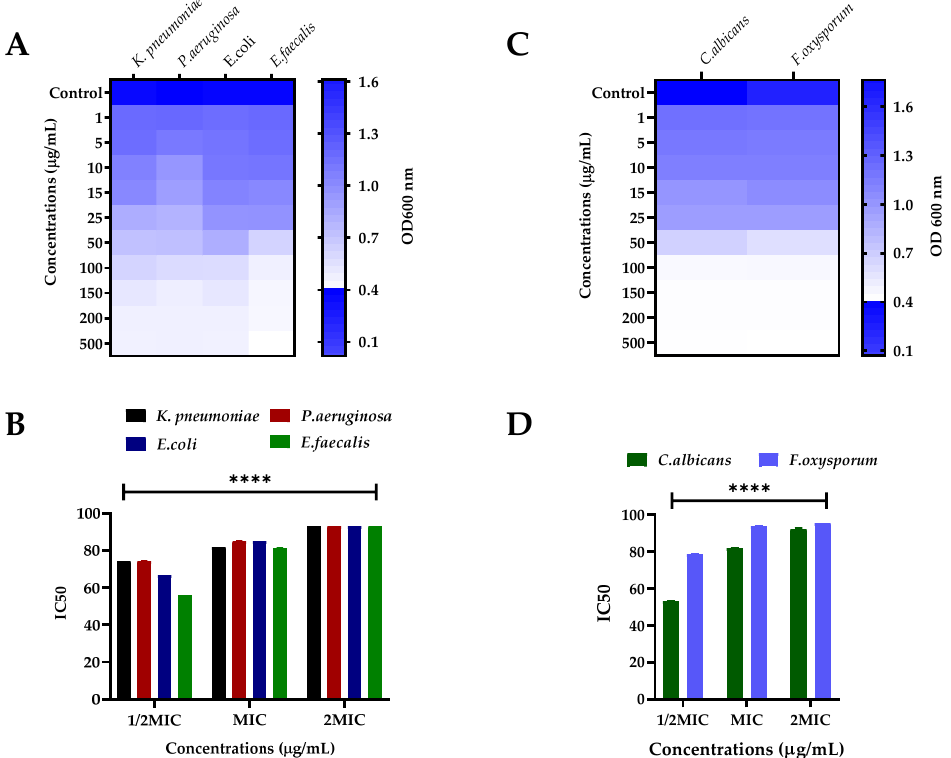
Figure 2. ( A ) Antibacterial OD 600 nm and IC 50 of Klebsiella pneumoniae , Pseudomonas aeruginosa , Escherichia coli , Enterococcus faecalis against various concentrations of crude oils of S. edelbergii and ( B ) MIC of the bacterial strains selected at various concentrations ( C ) antifungal OD 600 nm and IC 50 of the potential of oils of S. edelbergii against Candida albicans and Fusarium oxysporum against various concentrations Whereas, as ( D ). Represent the MIC against the fungal strains used. All Data were taken in triplicate ( n = 3) and analyzed through two-way ANOVA, via Tukey’s multiple comparison test, ns = > 0.9999, **** p = < 0.0001).